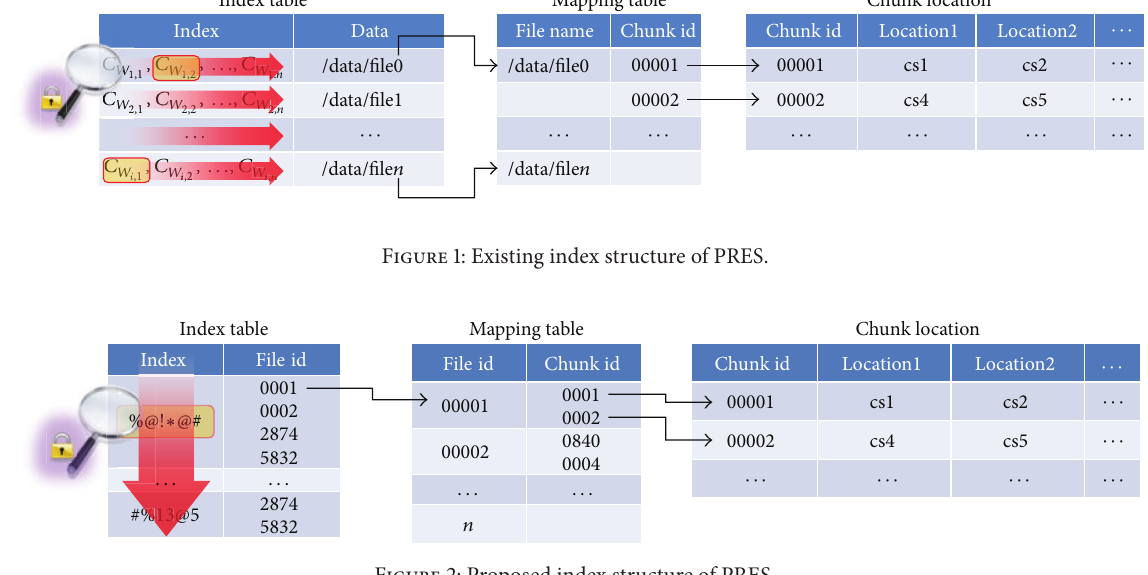
Figure 2: Proposed index structure of